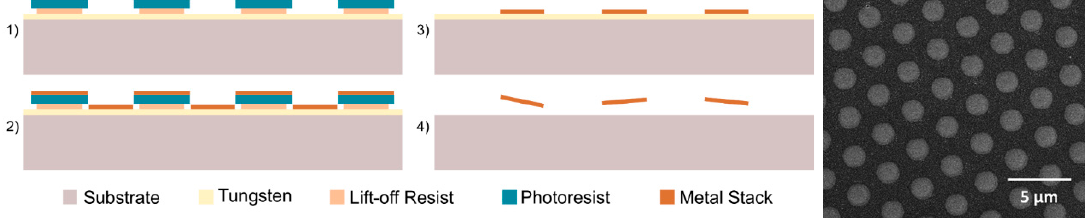
Figure 2. Microfabrication process of the magnetic microdiscs and scanning-electron microscopy (SEM) image of a densely-packed array of magnetic microdiscs on a substrate.